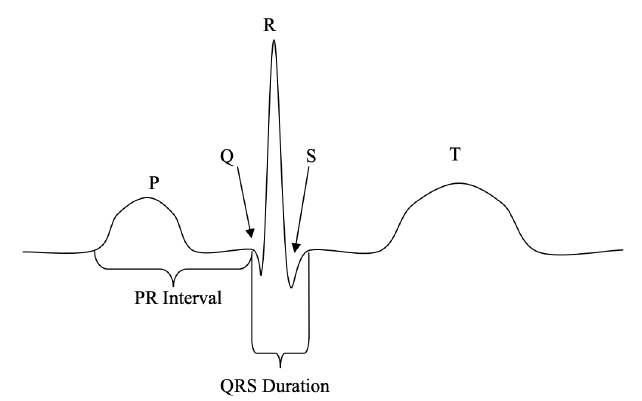
Figure 1. Fiducial points of P-QRS-T complex of ECG